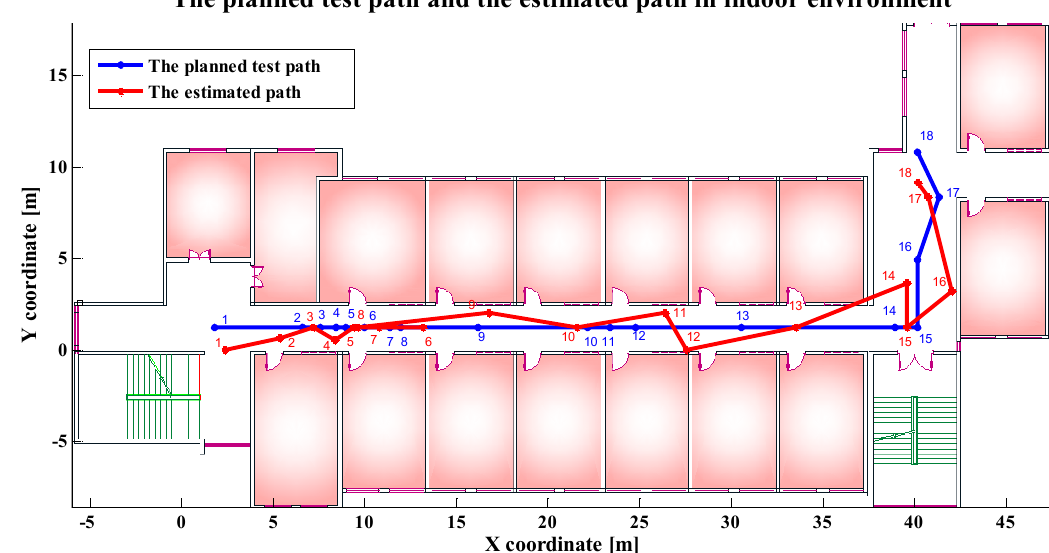
Figure 11. Comparison of the planned test path and the estimated path in indoor environment. Table 2. The errors between 18 planned test points and their corresponding estimated points.